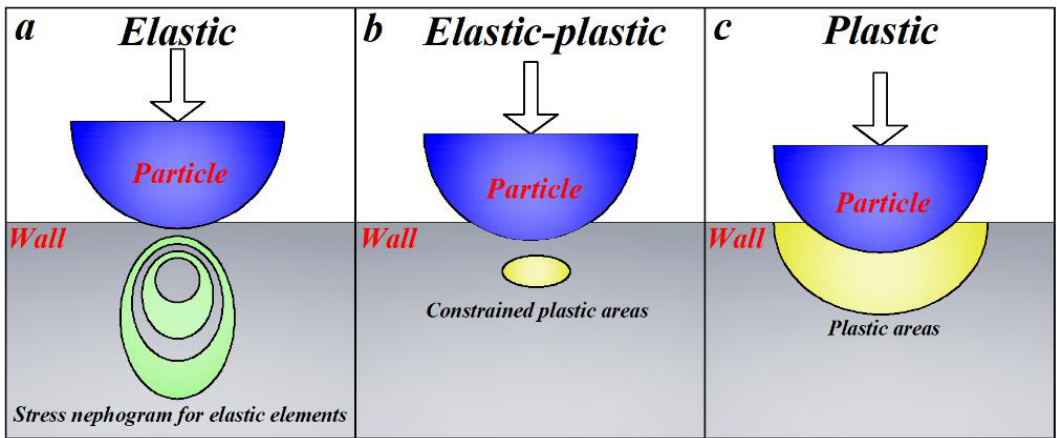
Figure 1. Schematic diagram of wall indentation caused by a rigid ball [19].